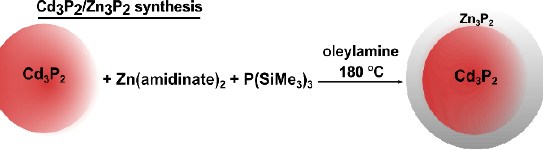
Scheme 1. Scheme detailing the synthesis of a Zn 3 P 2 shell on top of Cd 3 P 2